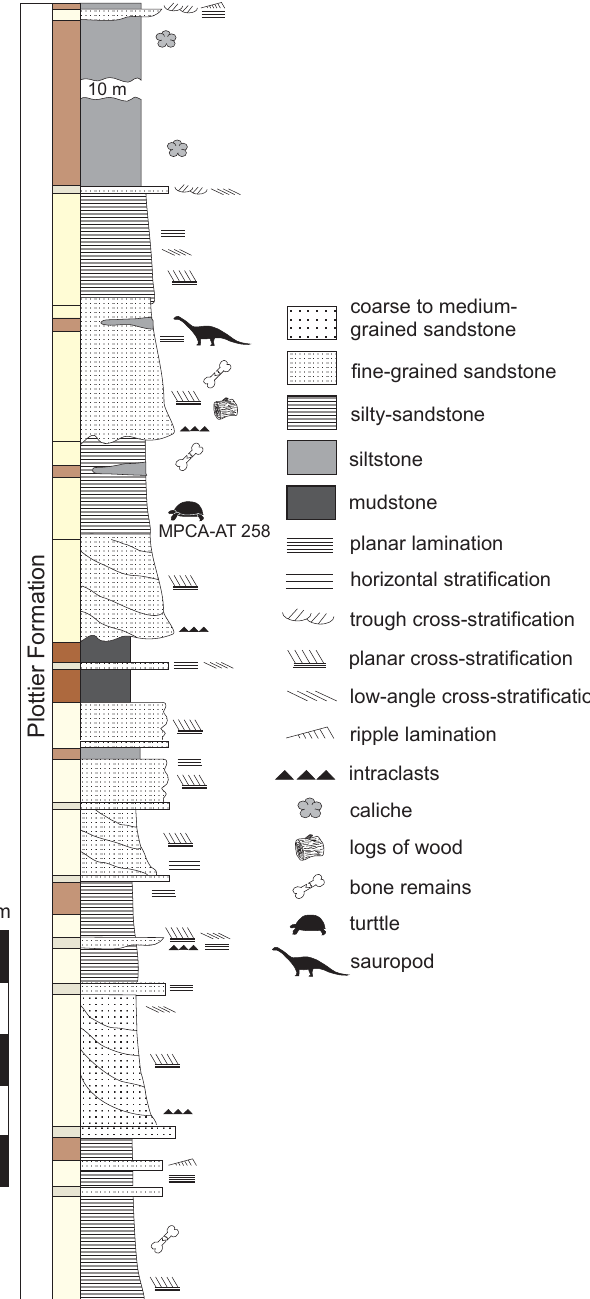
Fig. 2. Stratigraphic profile of the Plottier Formation outcrop, show- ing the levels where Rionegrochelys caldieroi de la Fuente, Maniel, and Jannello gen. et sp. nov. was recovered. Colours of deposits are in- dicated accord to Rock-Color Chart Committee (1991). Modified from Salgado et al.